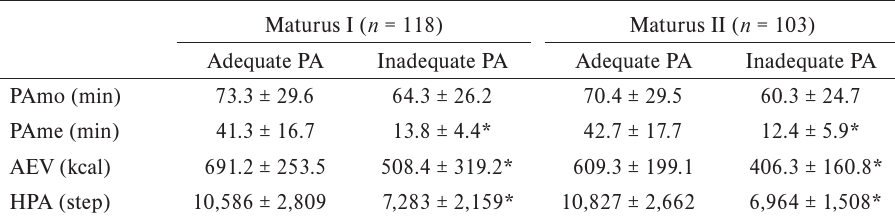
Differences analysis of selected physical activity